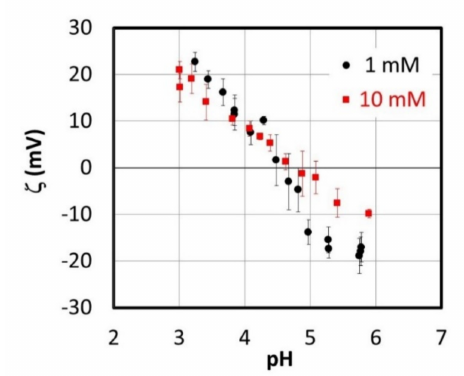
Figure 2. Zeta-potentials of Sample A NPs in 1 mM and 10 mM sodium nitrate